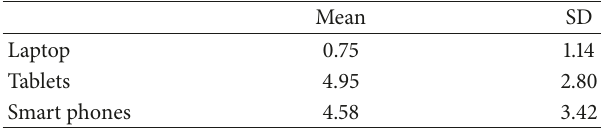
Table 1: Experience of using technology products of